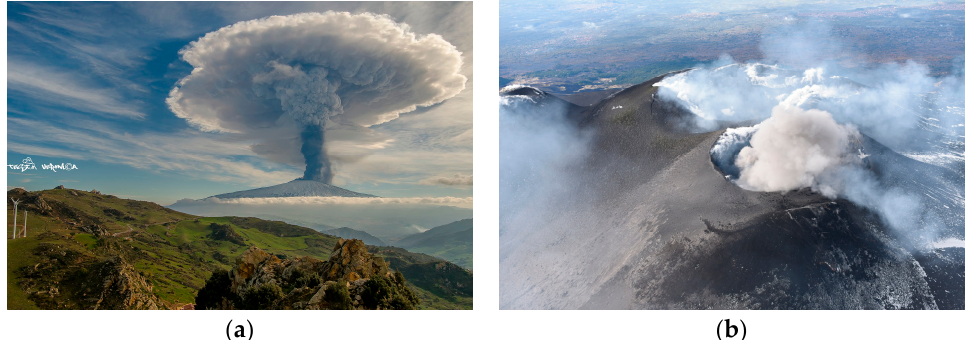
Figure 2. ( a ) Mt. Etna eruptive column of 4 December 2015, photograph courtesy of Veronica Testa; ( b ) Explosion from North East Crater (NEC) of 14 December 2015, photograph courtesy of Marco Neri.